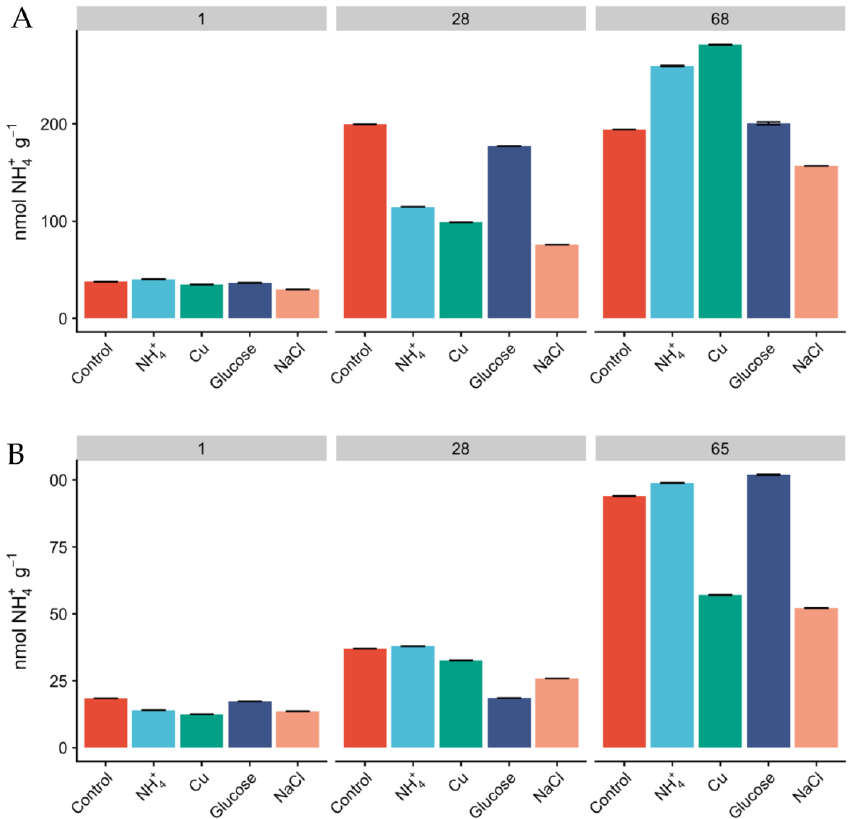
Figure 3. Concentration of 15 NH 4+ (nmol 1 5 NH 4+ g −1 ) in Miers ( A ) and Beacon ( B ) Valley soils over the course of the experiment, across the different treatments. Columns are mean values, and bars are the standard deviations of two replicates.